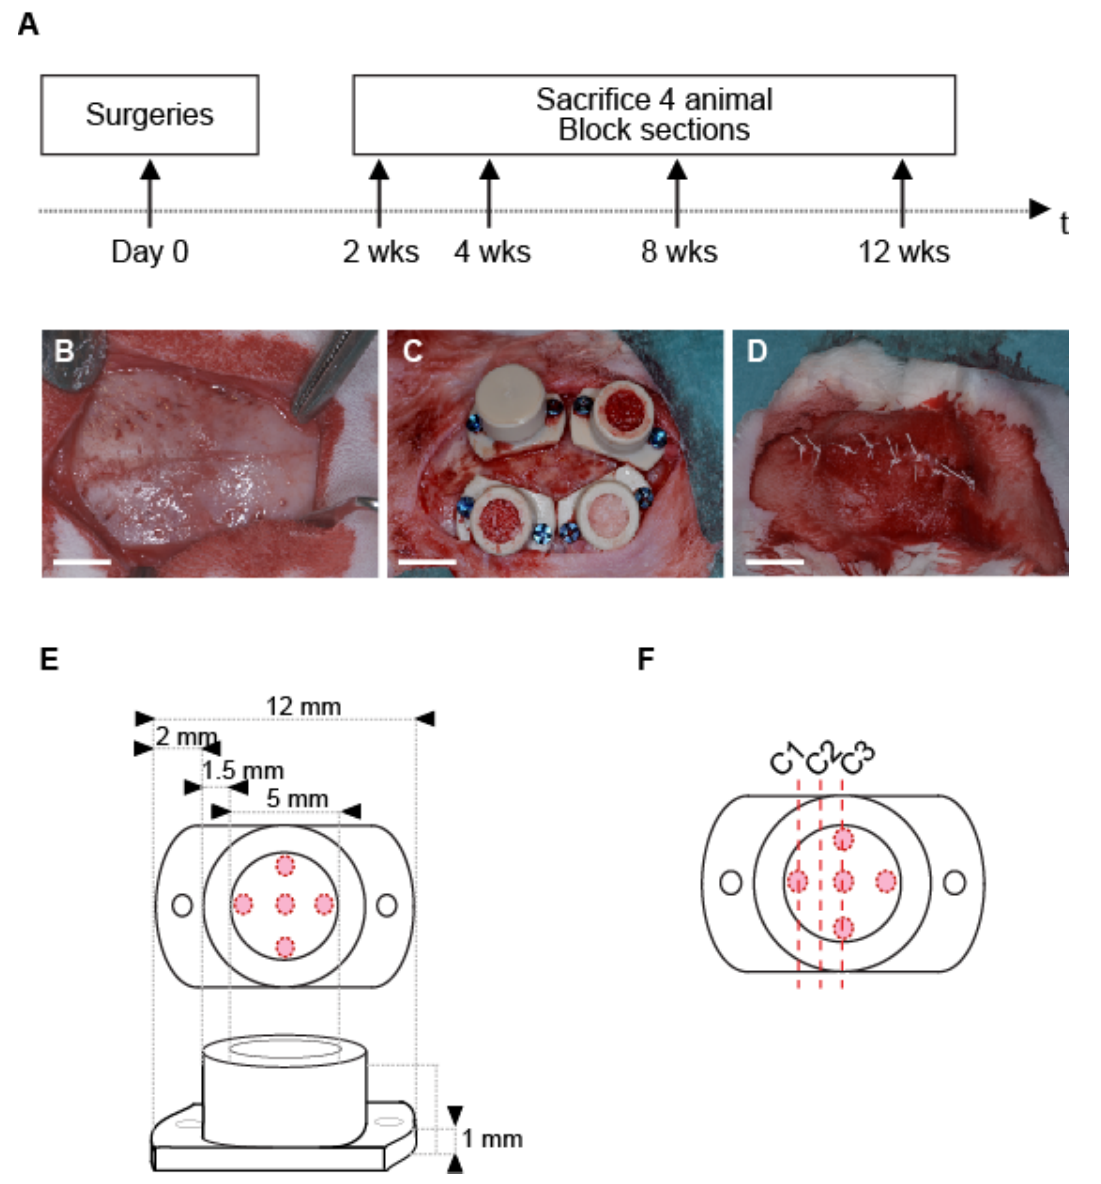
Figure 1. ( A ) Time frame of the study. ( B – D ) Main stages of the surgical procedure: ( B ) exposition of the calvarium, note the bone sutures that delineate 4 quarters; ( C ) placement and filling of the cylinders in the 4 quarters delimited by the bone sutures; ( D ) site suture; (white bars, 5mm); ( E ) Cylinder specification. Red circles mark the position of the intramedullary holes drilled on rabbit skulls; ( F ) Schema showing the three different levels of cut (C1–3) within the sample for histological and histomorphometric analyses.